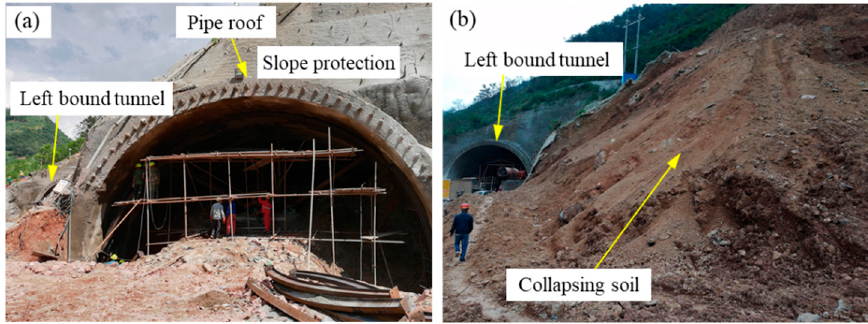
Figure 4. Photographs of the tunnel: ( a ) before collapse; ( b ) after collapse.